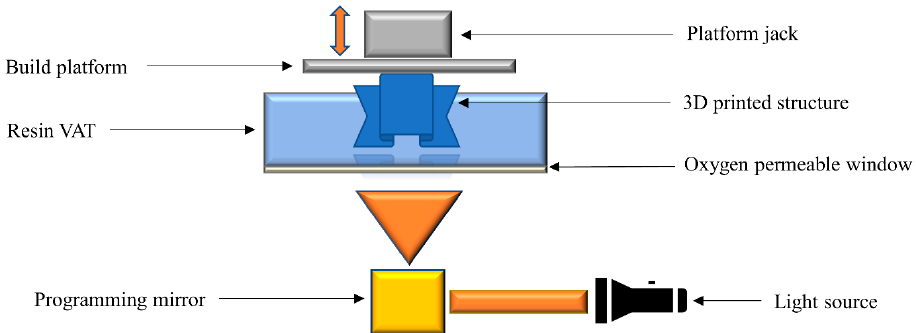
Figure 8. Schematic diagram of the continuous liquid interface printing (CLIP) process. Redrawn from [106].